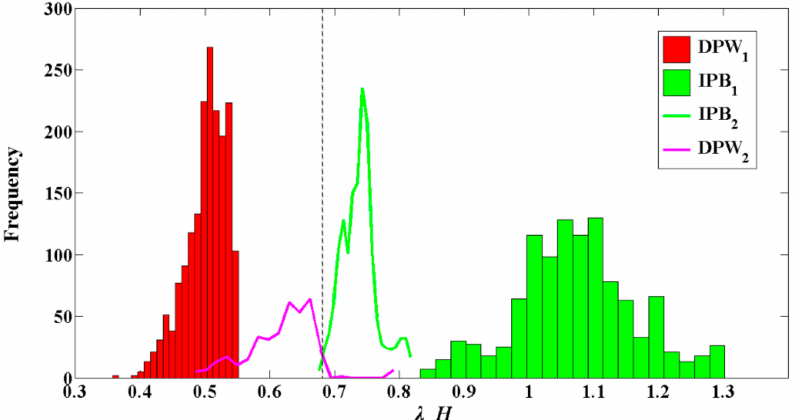
Figure 5. Comparison of histograms and histogram curves of parameter λ _H for the samples of intact parallel buildings and damaged parallel walls. DPW 1 , IPB 1 , IPB 2 , DPW 2 represent No. 1 sample of damaged parallel walls, No. 1 sample of intact parallel buildings, No. 2 sample of intact parallel buildings and No. 2 sample of damaged parallel walls, respectively. The location of the black dotted line denotes the threshold value for separating the damaged parallel walls and the intact parallel